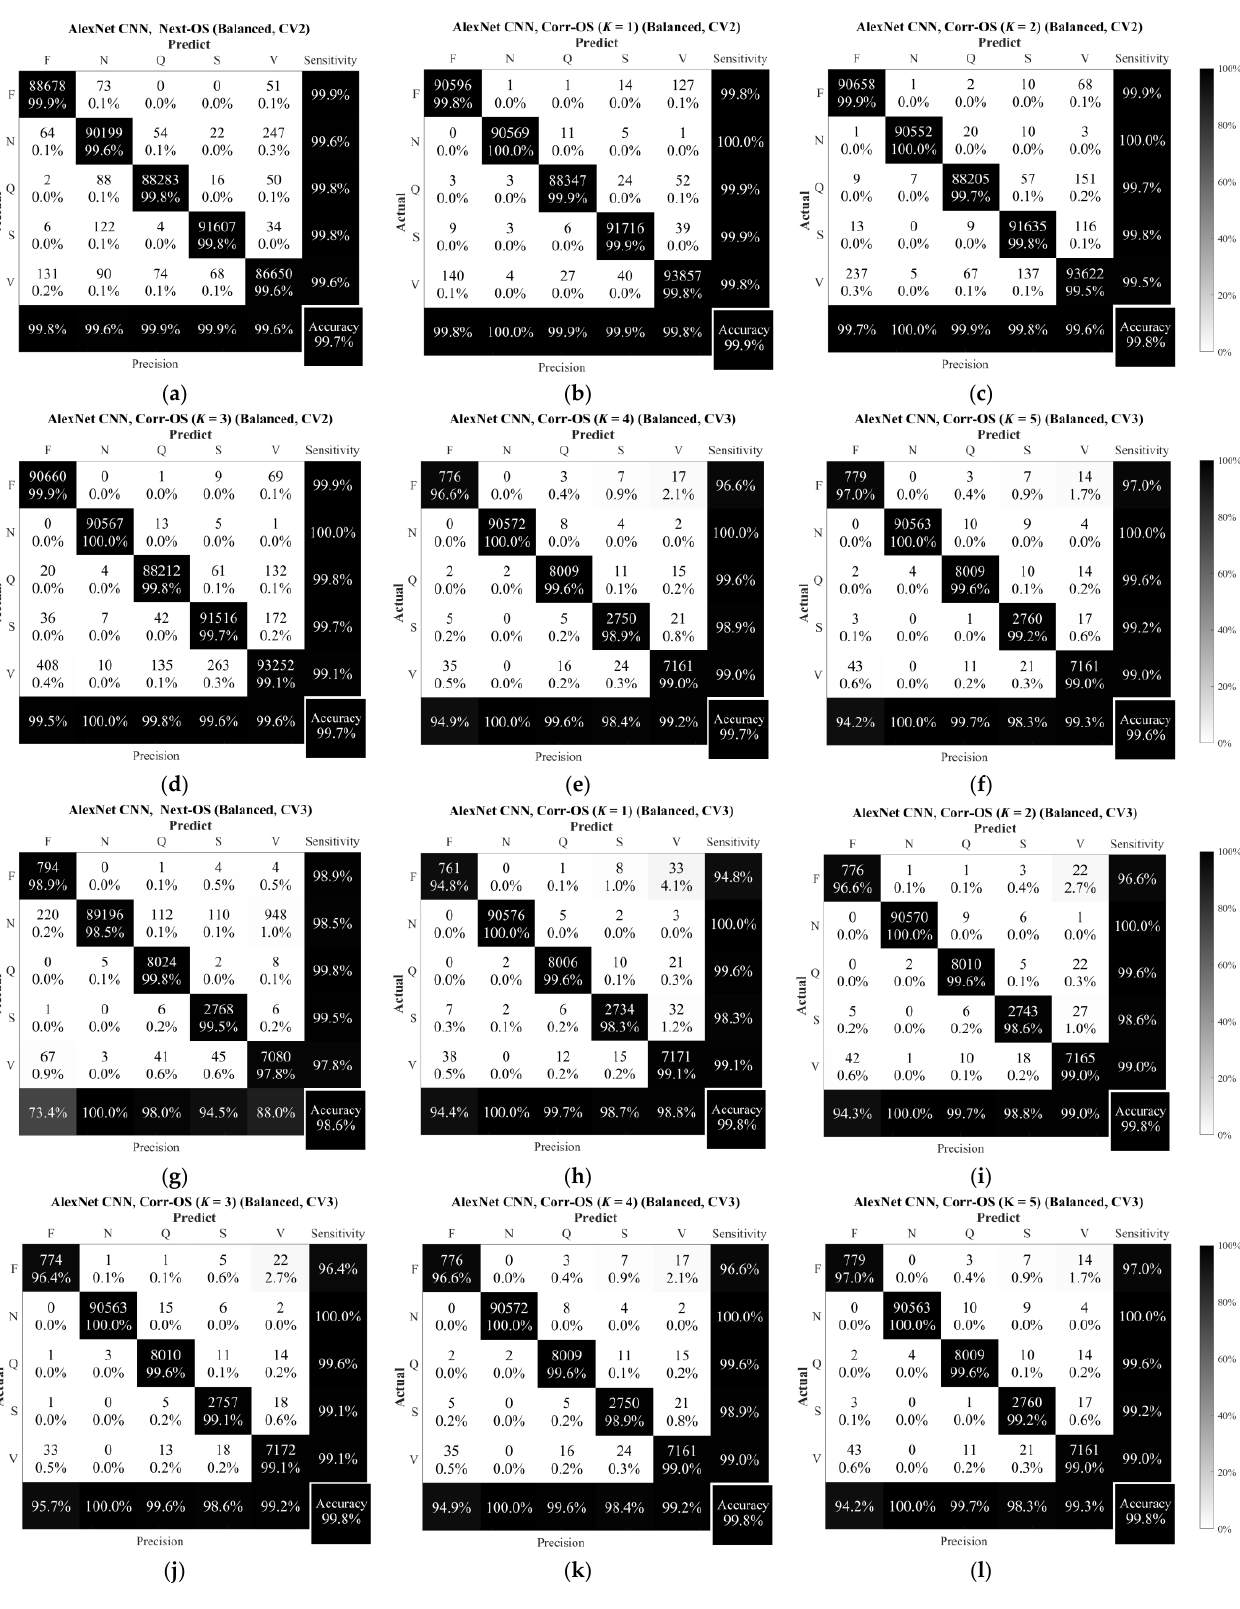
Figure A2. Confusion matrix of AlexNet using CV2 for ( a ) Next-OS, ( b ) Corr-OS ( K = 1), ( c ) Corr-OS ( K = 2), ( d ) Corr-OS ( K = 3), ( e ) Corr-OS ( K = 4), and ( f ) Corr-OS ( K = 5); using CV3 for ( g ) Next-OS, ( h ) Corr-OS ( K = 1), ( i ) Corr-OS ( K = 2), ( j ) Corr-OS ( K = 3), ( k ) Corr-OS ( K = 4), and ( l ) Corr-OS ( K = 5).